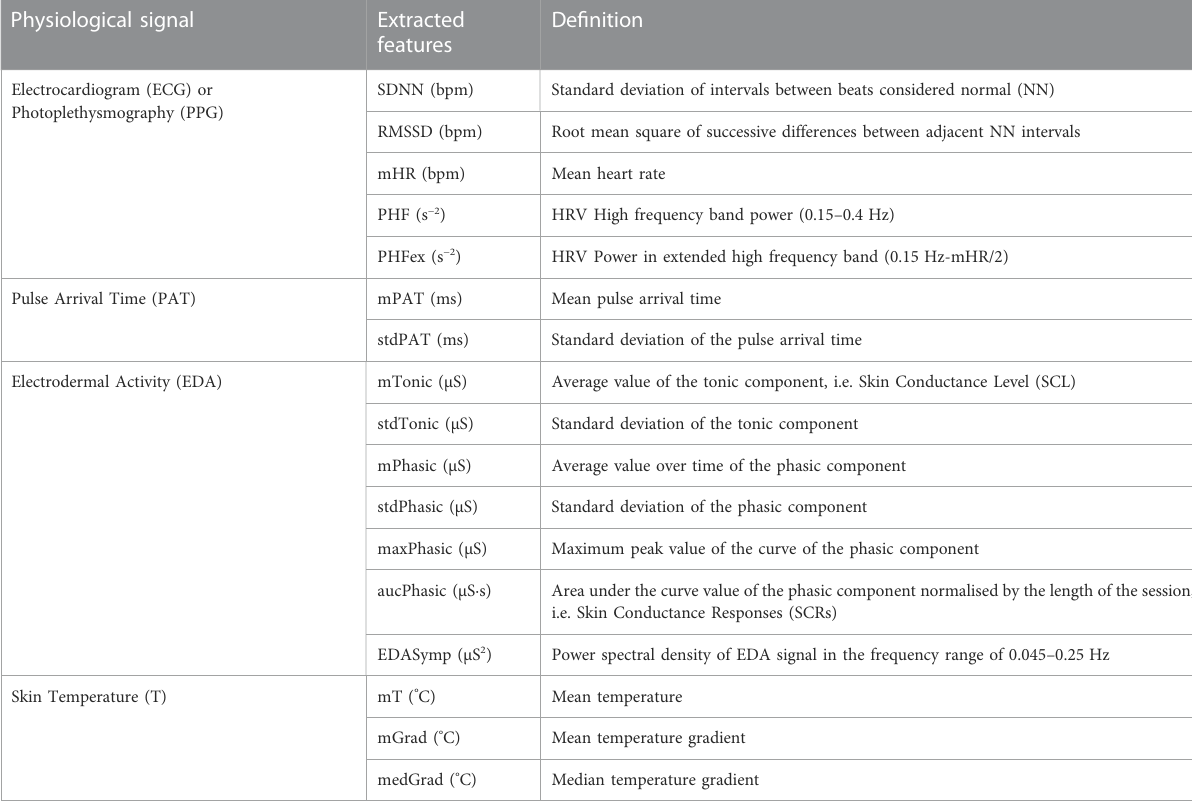
TABLE 1 List of extracted features from physiological signals. Physiological signal Extracted